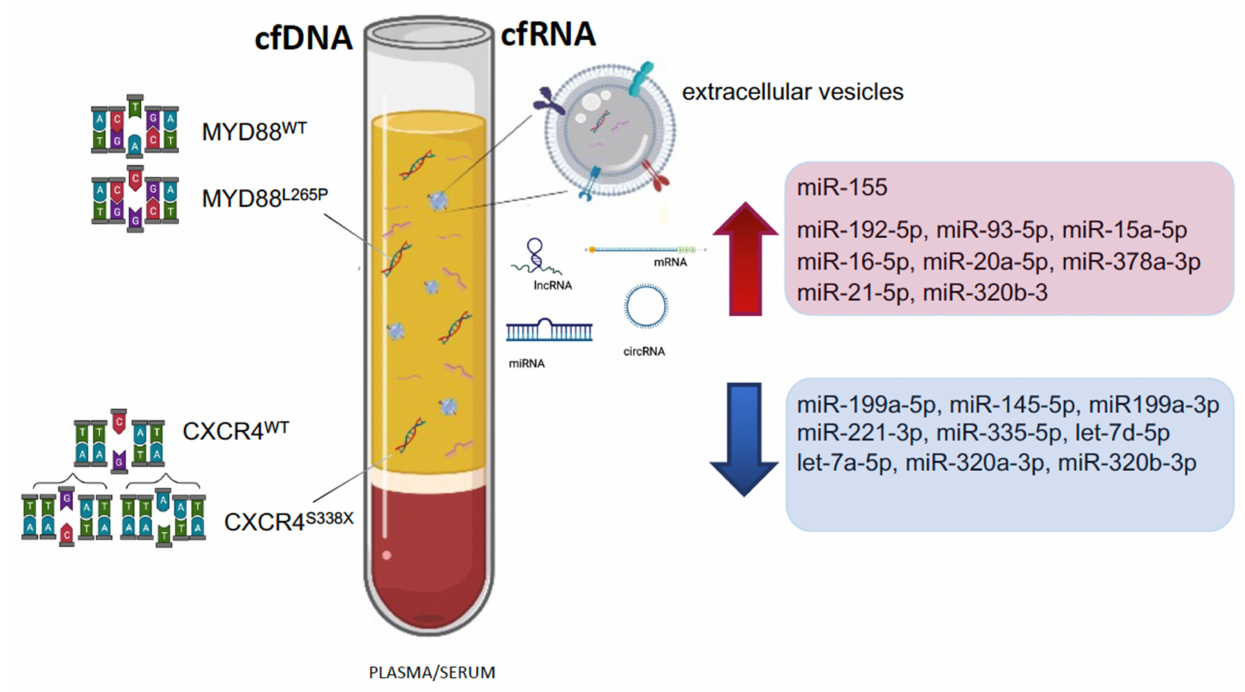
Figure 4. Cell-free DNA (cfDNA) and cell-free RNA (cfRNA) markers in plasma or serum of WM patients. Significant up- and downregulated miRNAs are shown